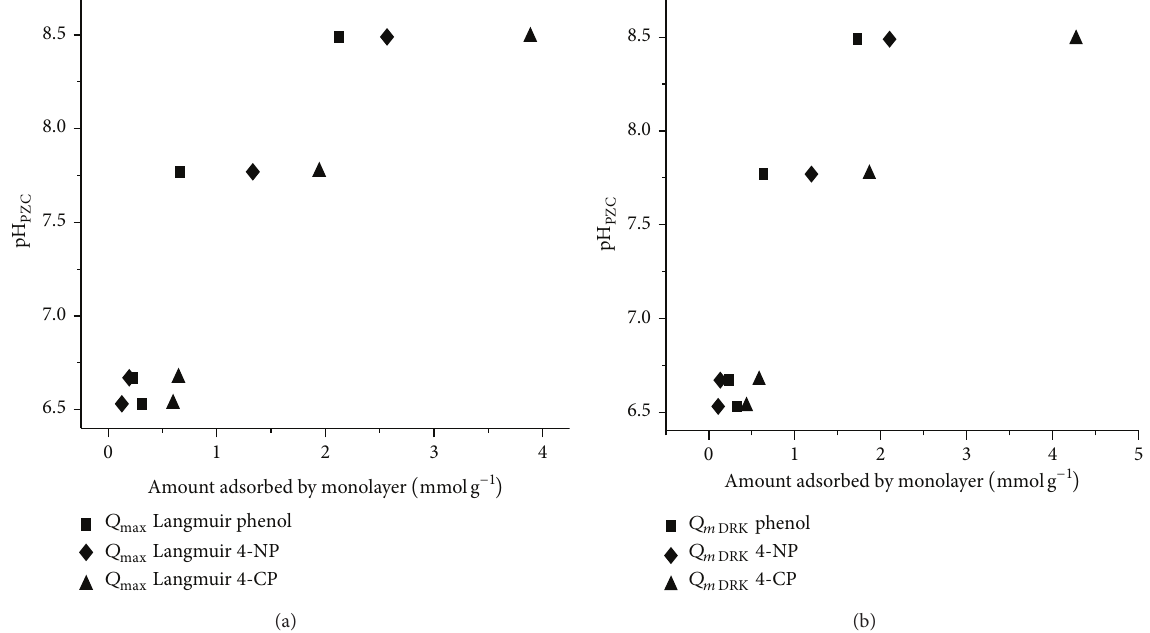
Figure 9: Correlation between pH PZC and maximum amount adsorbed of phenols on